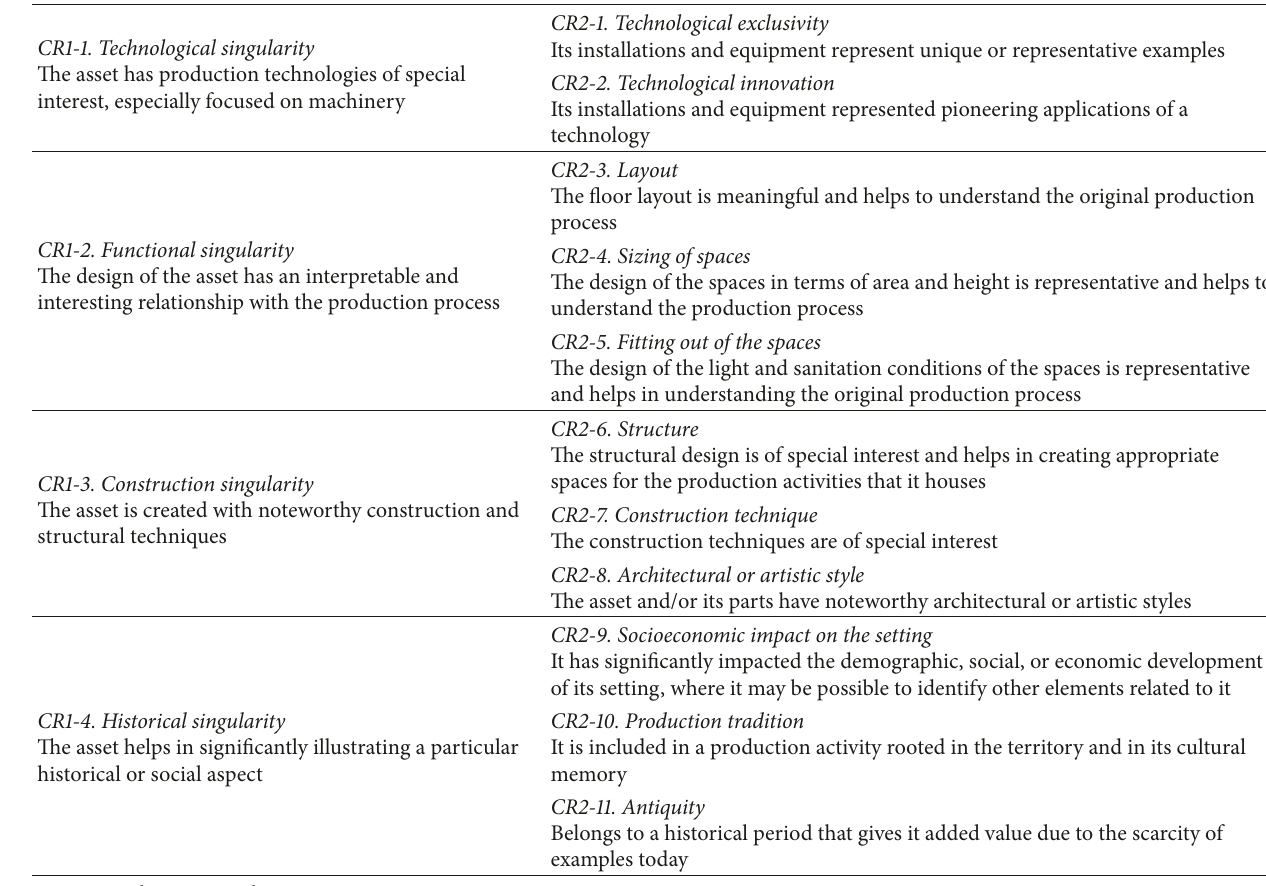
Table 1: Heritage assessment criteria.